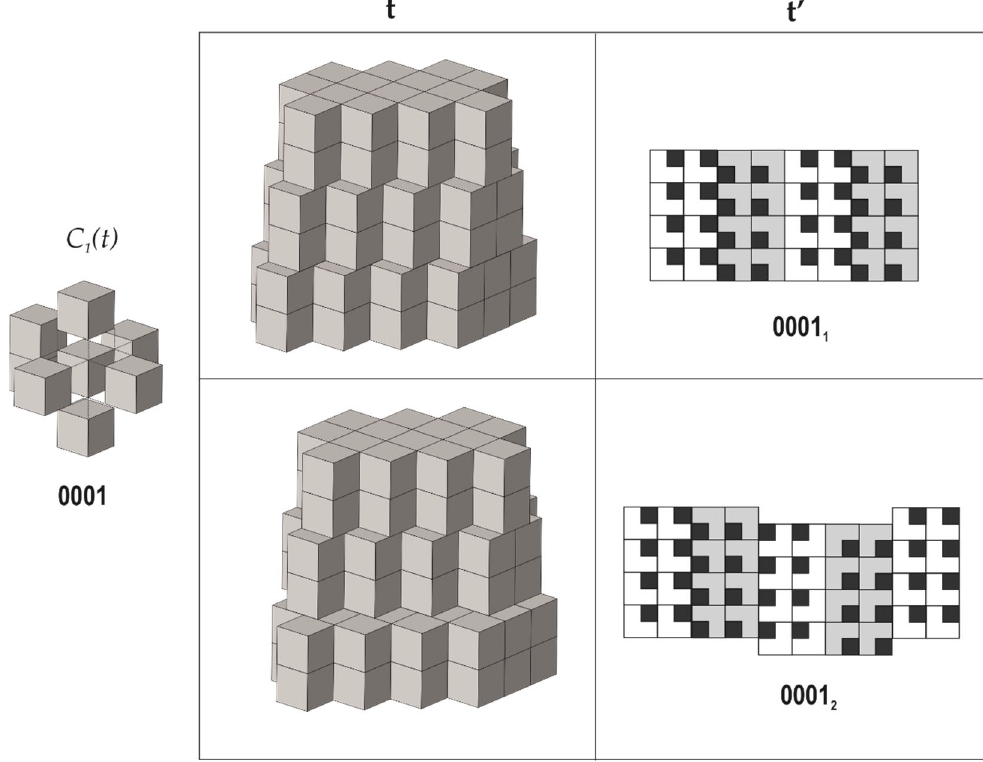
Figure 5. Arrangements of the pseudo ‐ cubic modules in lovozerite ‐ type structures with 0001 local environment. Legend as in Figure 3. Modified after [70].